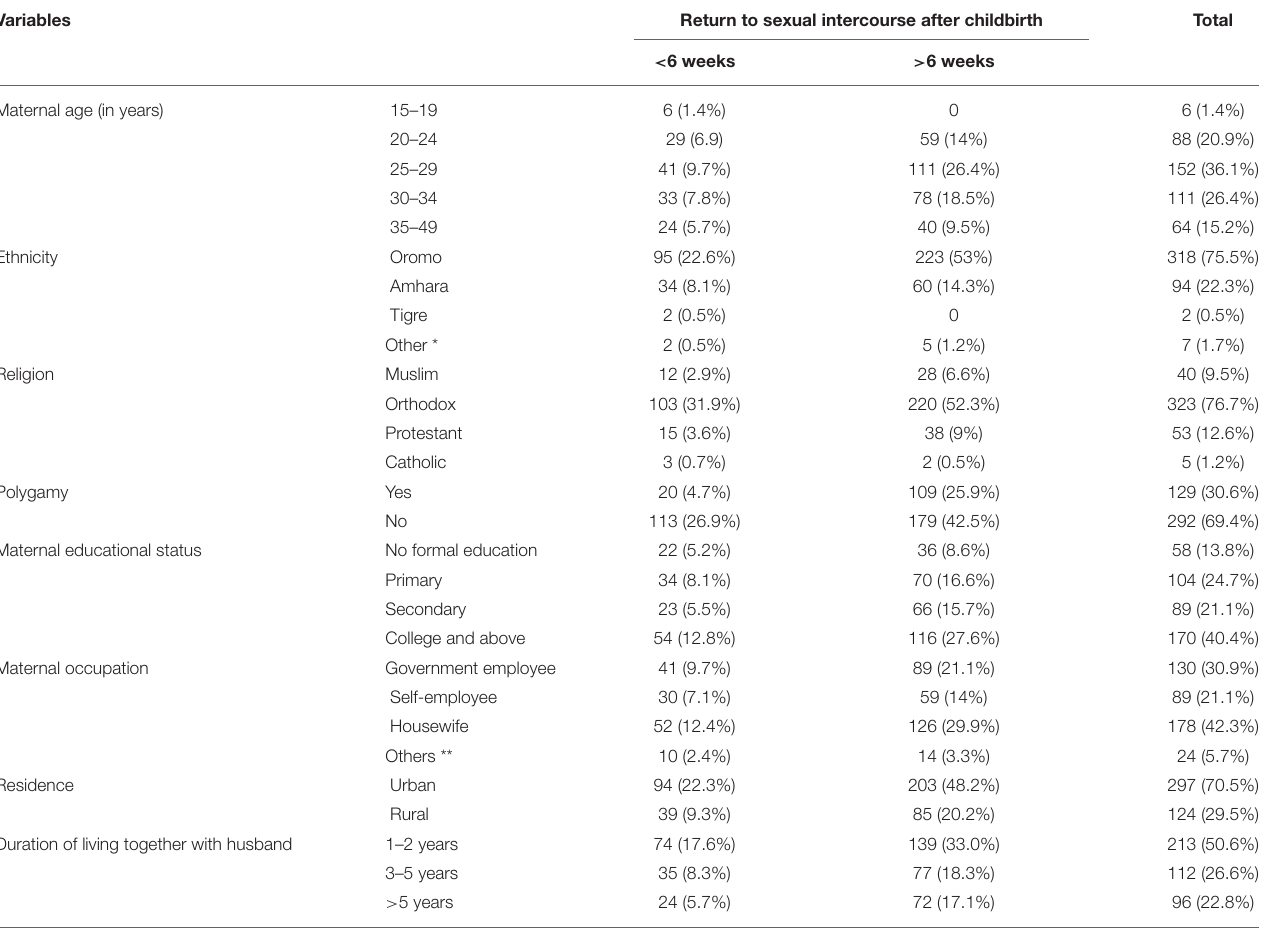
TABLE 1 | Socio-demographic characteristics of post-partum women at Salale University comprehensive specialized teaching hospital, September to October 2021 ( n = 421).